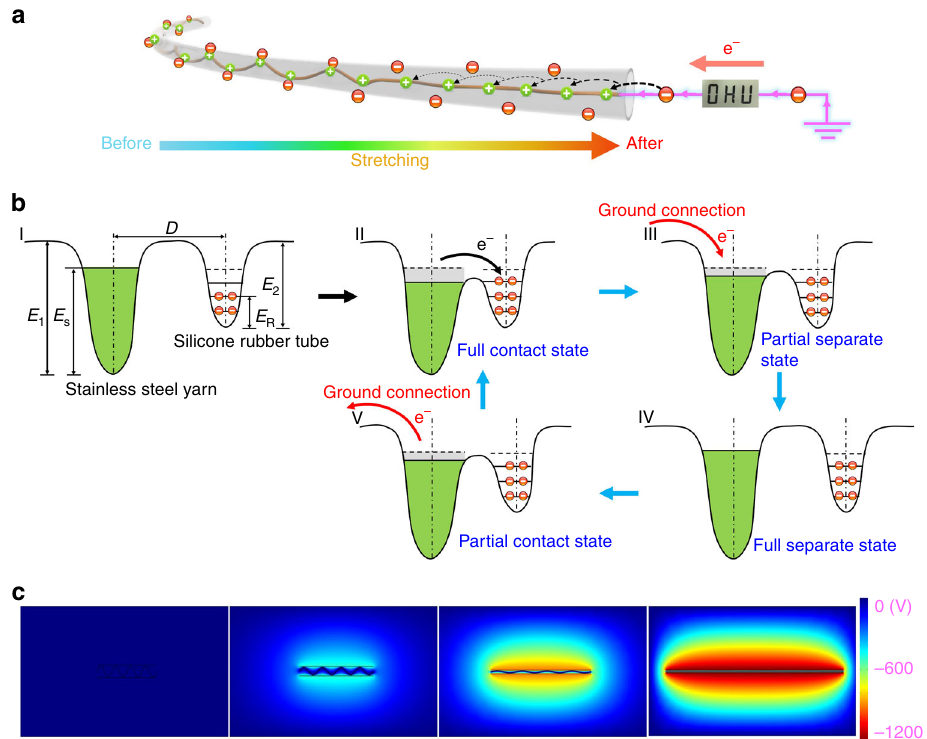
Fig. 2 Working mechanism of the single-electrode triboelectric yarn. a Kinetic demonstration of the stretching process of the SETEY. b A potential well model proposed for explaining charge transfer during the contact and separation of two materials under a single electrode. D is the distance between potential wells of inner stainless steel yarn and silicone rubber tube sheath, E S and E R are the occupied energy levels of electrons in the atoms of stainless steel yarn and silicone rubber tube, E 1 and E 2 are the required potential energies for electrons to escape from the surfaces of stainless steel yarn and silicone rubber tube, respectively. E S and E R are respectively smaller than E 1 and E 2 . c Simulation results of the potential distribution of the SETEY by using COMSOL software. From left to right: the potential on the silicone tube gradually increases and the potential on the stainless steel yarn remains stable. SETEY single-electrode triboelectric